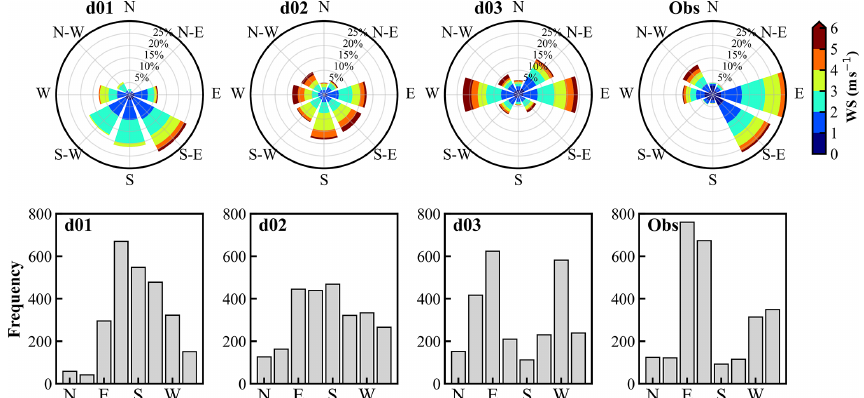
Figure 8. Comparison of the wind speed and direction represented by the wind rose (top panel) and the frequency distribution of the wind direction (bottom panel) for model simulations over the three domains (d01, d02, d03) and observations (obs) during June–September 2011. Different colors and radii of wind roses show the wind speed and frequency of occurrences, respectively.